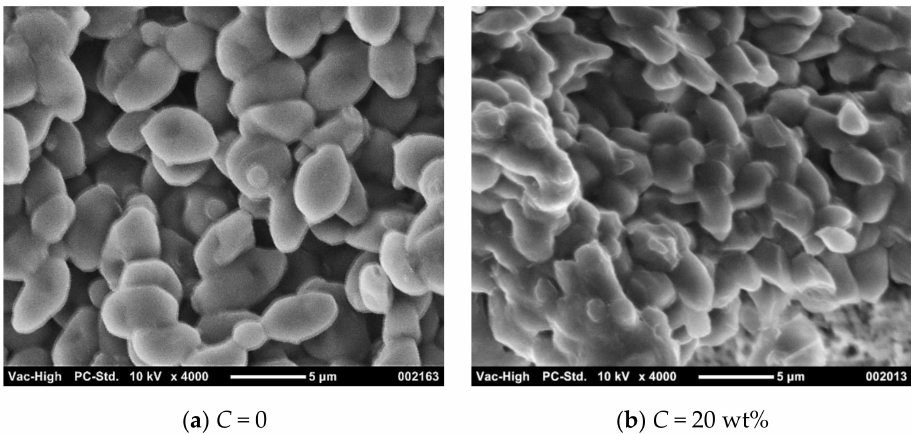
Figure 6. Electron micrograph of filter cake ( s c = 0.078, p = 50 kPa): ( a ) C = 0; ( b ) C = 20